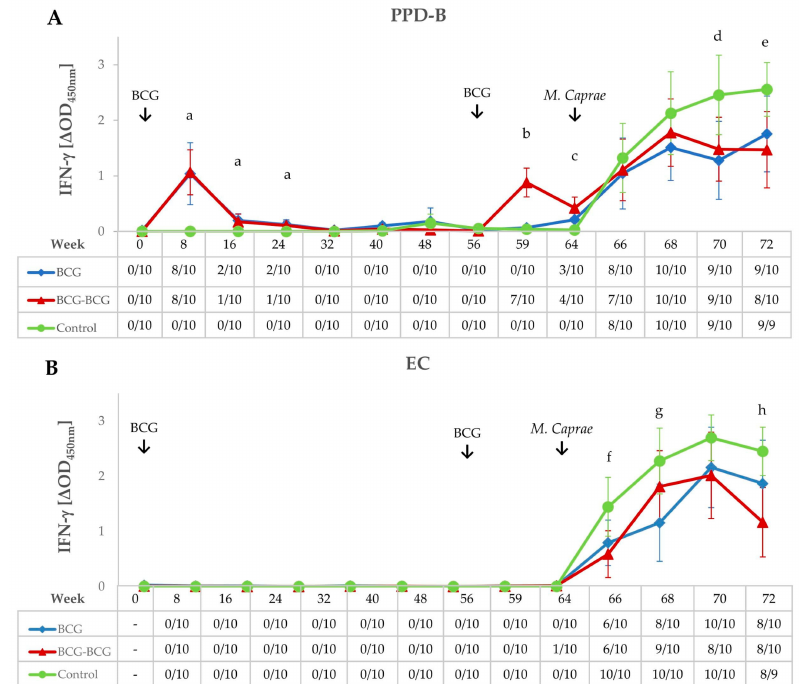
Figure 2. IFN- γ responses after bacillus Calmette–Guerin (BCG) vaccination, revaccination, and M. caprae challenge. ( A , B ) Mean IFN- γ levels released after stimulation whole blood with M. bovis tuberculin (PPD-B) and ESAT-6 / CFP-10 (EC) DIVA reagent, respectively. Tables on horizontal axes show IFN- γ release assay (IGRA) qualitative results for each time point. BCG (blue): single BCG-vaccinated group, BCG-BCG (red): BCG revaccinated group, Control (green): unvaccinated group. Kruskal–Wallis test with post-hoc Wilcoxon test: (a) BCG and BCG-BCG compared to Control, p < 0.01; (b) BCG-BCG compared to BCG and Control, p < 0.001; (c) BCG and BCG-BCG compared to Control, p < 0.001; LMER with pairwise comparisons; (d) BCG and BCG-BCG compared to Control, p < 0.05; (e) BCG and BCG-BCG compared to Control, p < 0.05 and p < 0.01, respectively; (f) BCG-BCG compared to Control, p < 0.05; (g) BCG compared to Control, p < 0.05, (h) BCG-BCG compared to Control, p < 0.01.